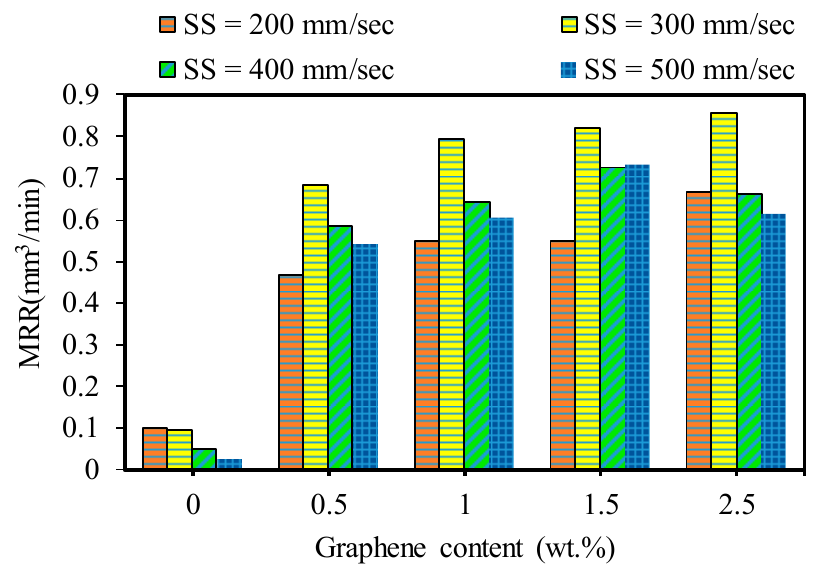
Figure 20. Effects of varying graphene contents with laser speed on MRR. At F = 30 kHz.